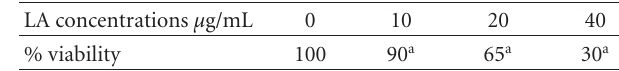
Table 1: E ff ect of di ff erent concentrations of α -lipoic acid (LA) on the percentage viability of Ehrlich ascites carcinoma (EAC) cells in vitro . LA concentrations μ g/mL 0 10